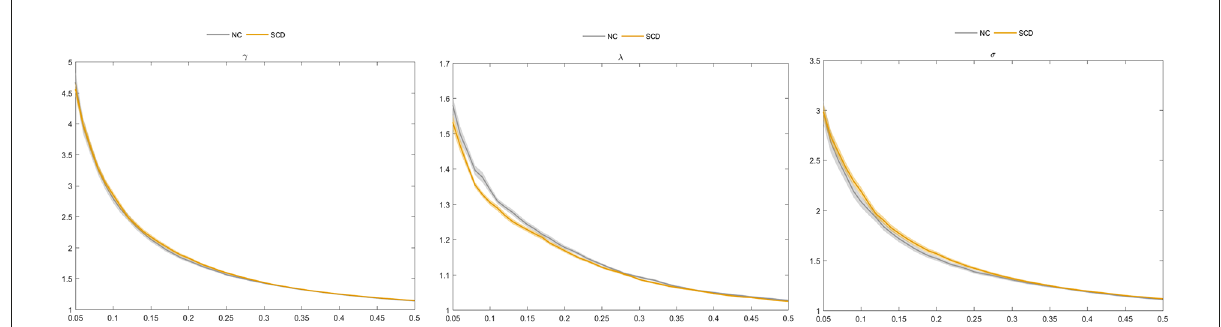
FIGURE2 Comparison of normalized clustering coefficient ( γ ), normalized characteristic path length ( λ ), and “small world” ( σ ) between the subjective cognitive decline (SCD) and normal control (NC)